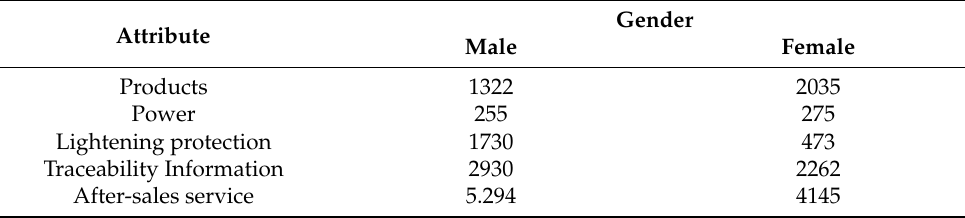
Table 11. Calculated WTP values by gender